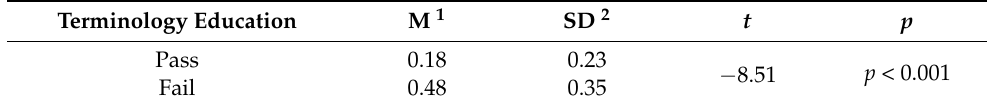
Table 2. Results of unpaired T-test for hypothesis 3 for terminology education.